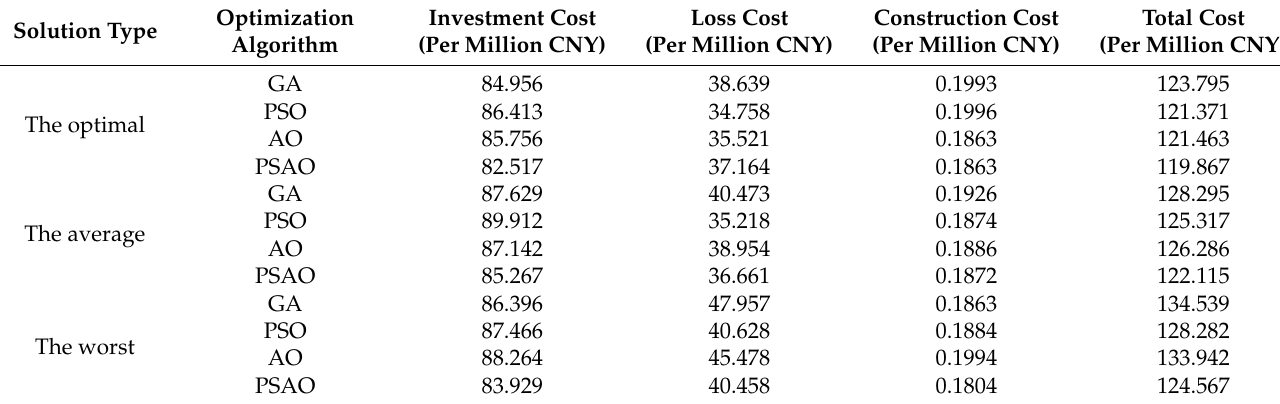
Table 4. Statistical table of optimal